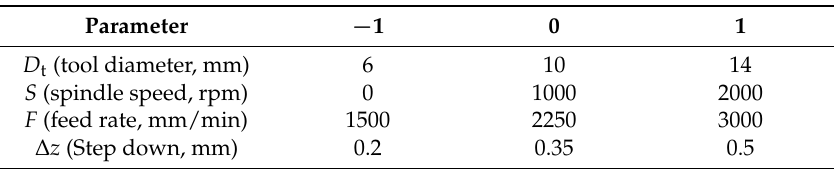
Table 1. Parameters and levels considered in the Box–Behnken (BB) design for SPIF of PCL and UHMWPE